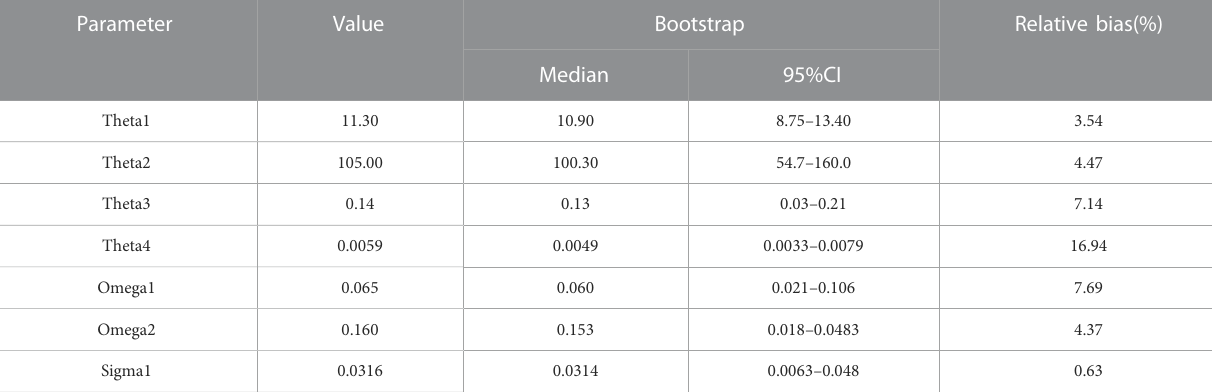
TABLE 2 PK parameters and bootstrap results of fi nal model.